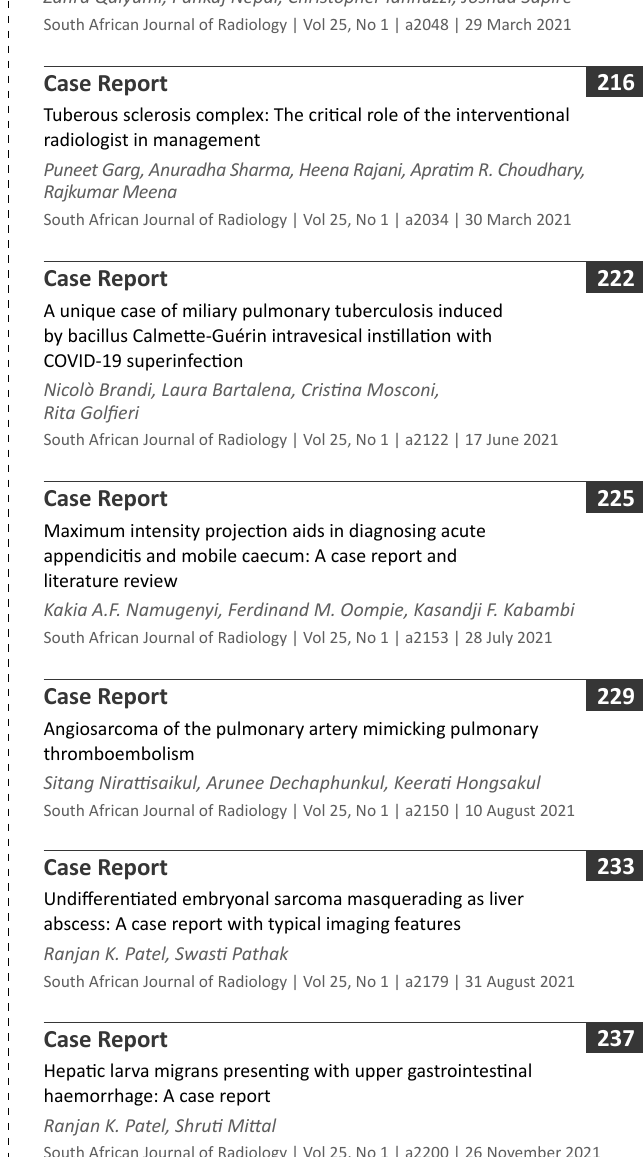
A kaleidoscopic view of male urethral pathologies on 64-slice multidetector computed tomographic urethrography: A novel technique